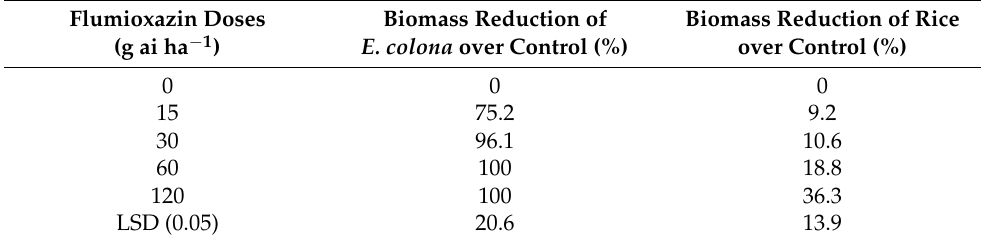
Table 3. Effect of flumioxazin on percent biomass reduction of Echinochloa colona control and rice. LSD: Least significant differences at 5% level of